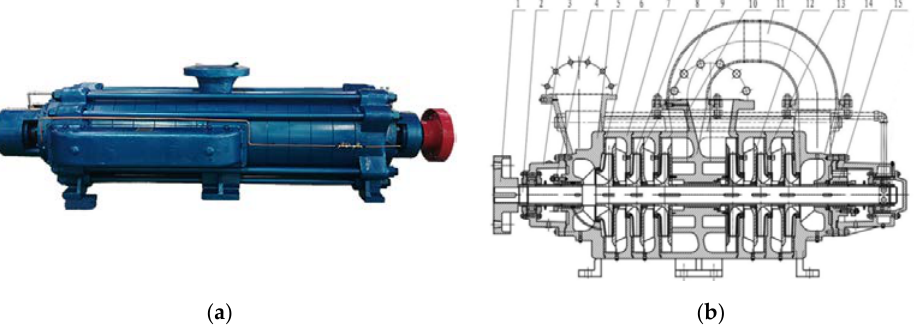
Figure 11. MD650-80×12P self-balancing multistage pump. ( a ) Drawing of the MD650-80×12P self- Figure 11. MD650-80 × 12P self-balancing multistage pump. ( a ) Drawing of the MD650-80 × 12P balancing multistage pump. ( b ) Design of the MD650-80×12P self-balancing multistage pump. 1— self-balancing multistage pump. ( b ) Design of the MD650-80 × 12P self-balancing multistage